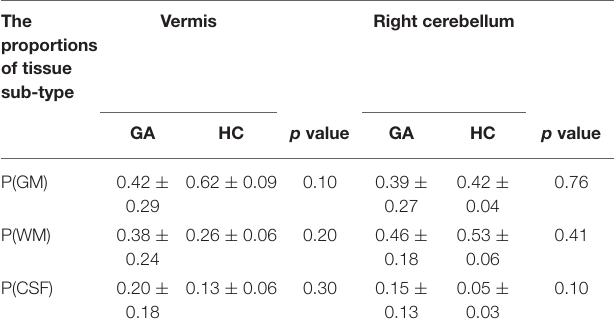
TABLE 5 | The proportions (mean ± SD) of gray matter P(GM), white matter P(WM), and cerebrospinal fluid in P(CSF) in the voxel placed during MRS in the vermis and right cerebellum of patients with gluten ataxia (GA) and healthy controls (HC). The